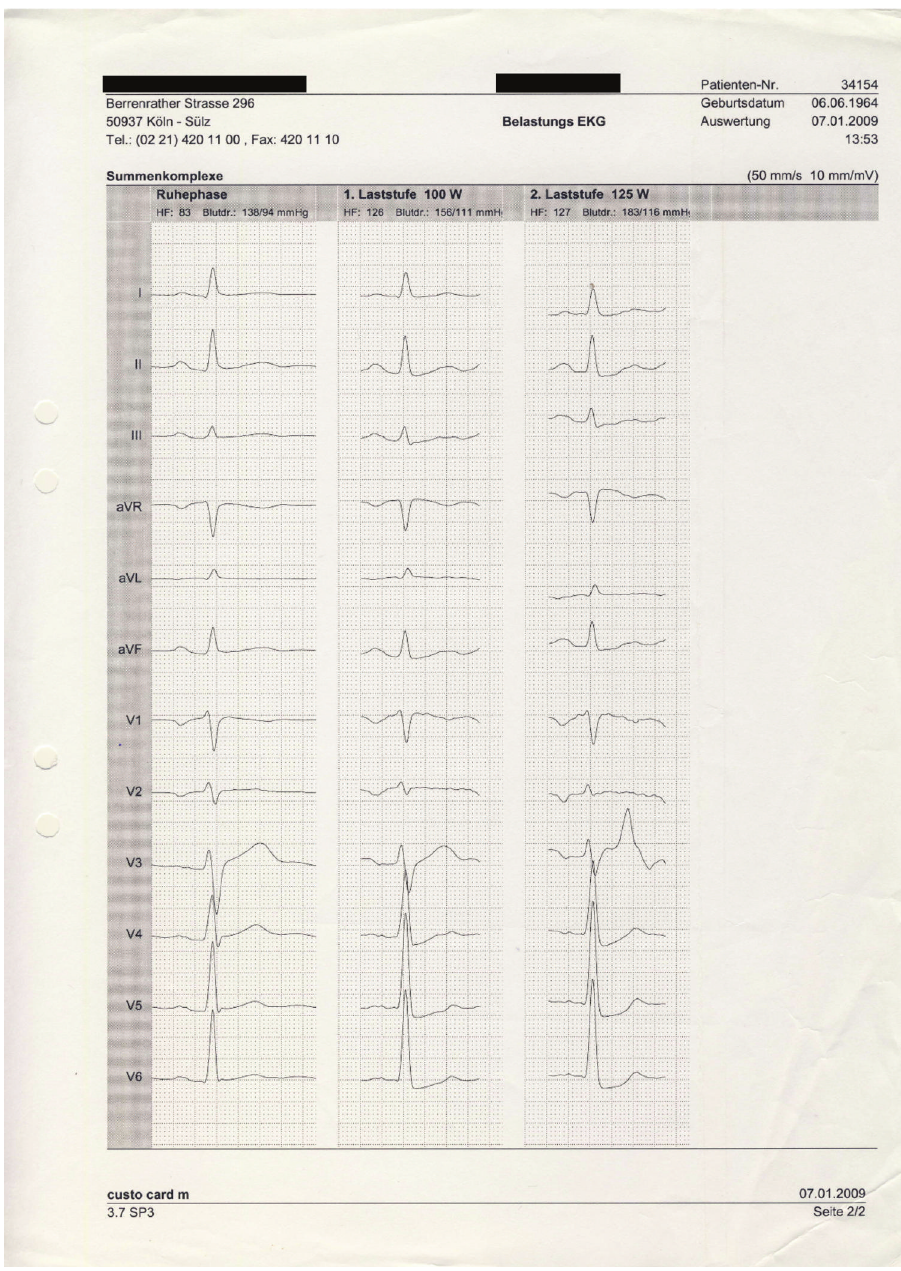
Figure 1: 12-lead electrocardiogram demonstrating significant ST-depression in the posterior leads during exercise.